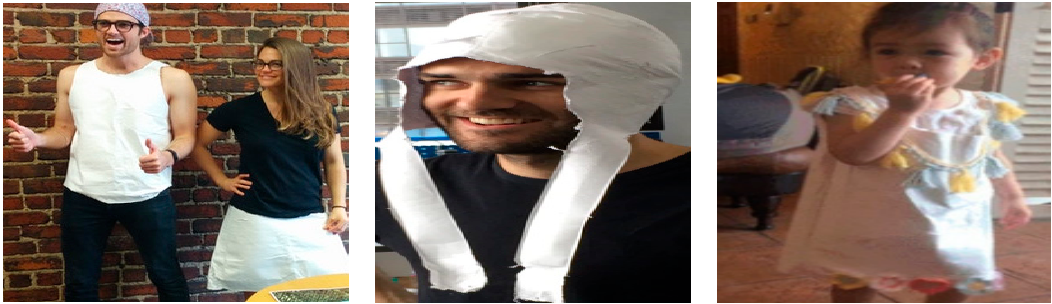
Figure 13. Products manufactured by Electro-Loom (white color products without decorations) [103]